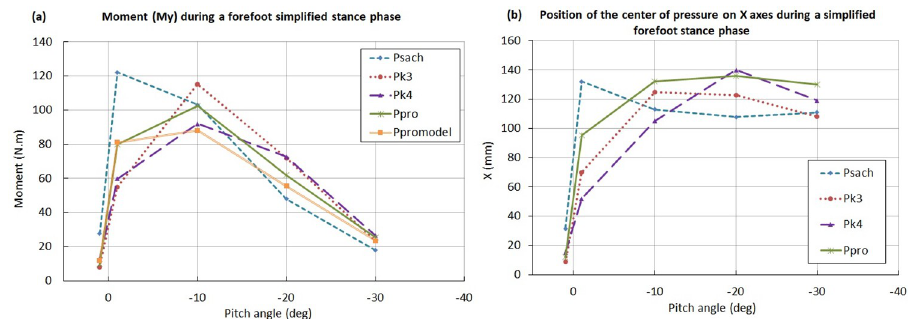
Fig 9. Evaluation of the load-deflection response. (a) Moment My of different during forefoot stance phase (from 0 to -30deg). (b) Representation of the position of the center of pressure on the X-axis.